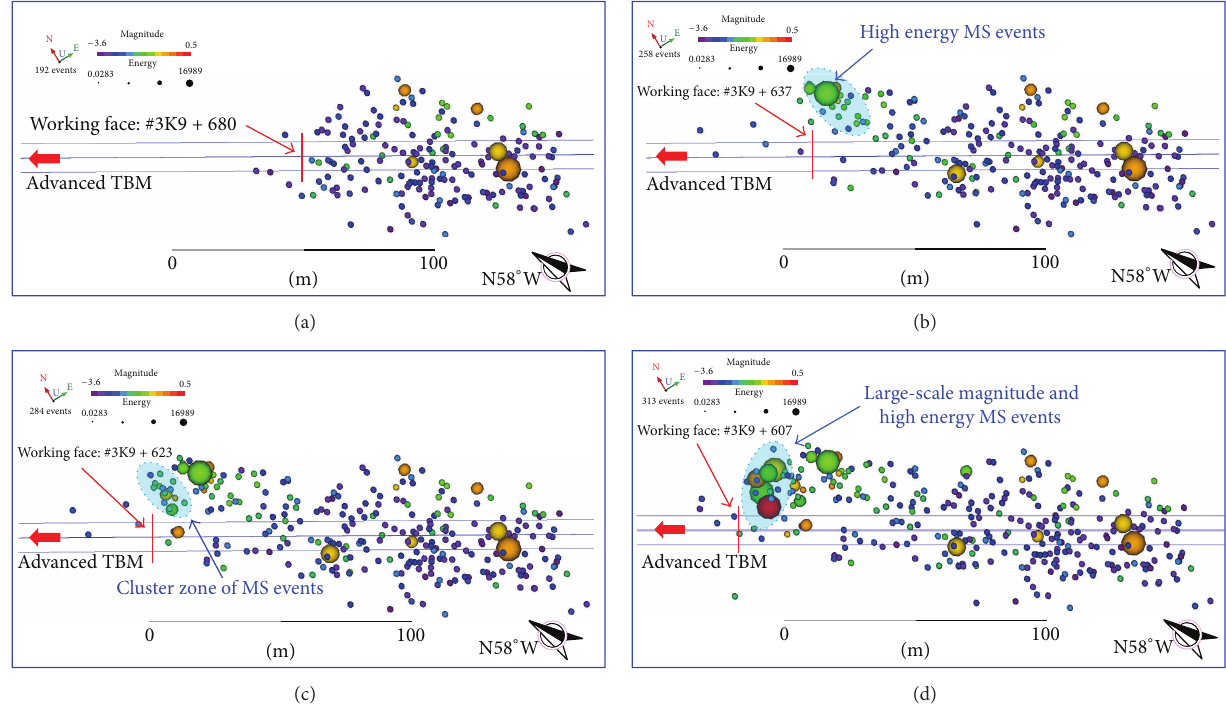
Figure 7: A projection map of the spatiotemporal distribution of microseismicity during TBM tunneling in diversion tunnel #3 (January 20 to February 21, 2011). (a) Microseismicity distribution from January 20 to February 5, 2011; (b) microseismicity distribution from January 20 to February 10, 2011; (c) microseismicity distribution from January 20 to February 16, 2011; and (d) microseismicity distribution from January 20 to February 21, 2011.